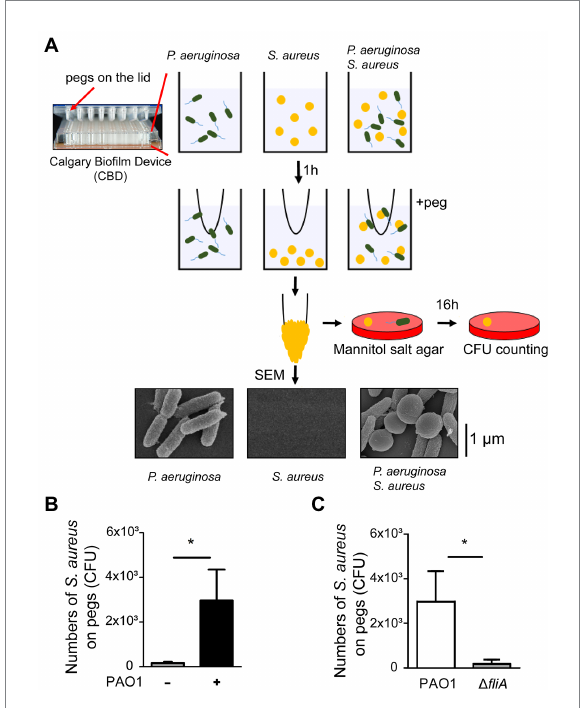
FIGURE 1 Promotion of Staphylococcus aureus movement by motile Pseudomonas aeruginosa . (A) Assay of S. aureus SA113 movement prompted by swimming P. aeruginosa PAO1. Bacteria were cultured in wells of CBD plates. After incubation for 1 h, the pegs on the lid were immersed into the culture for 30 s. Staphylococcus aureus adhered on the pegs was enumerated by viable cell count. Bacteria on pegs were also examined by SEM. (B,C) Wells were seeded with S. aureus SA113 only or mixed with P. aeruginosa PAO1 or its Δ fliA mutant strain. The number of S. aureus SA113 adhered on pegs was determined. Data are presented as the mean of the results from more than three independent experiments and were analyzed statistically using Student’s t test. Error bars indicate standard deviations. Significant differences ( p < 0.05) are denoted with